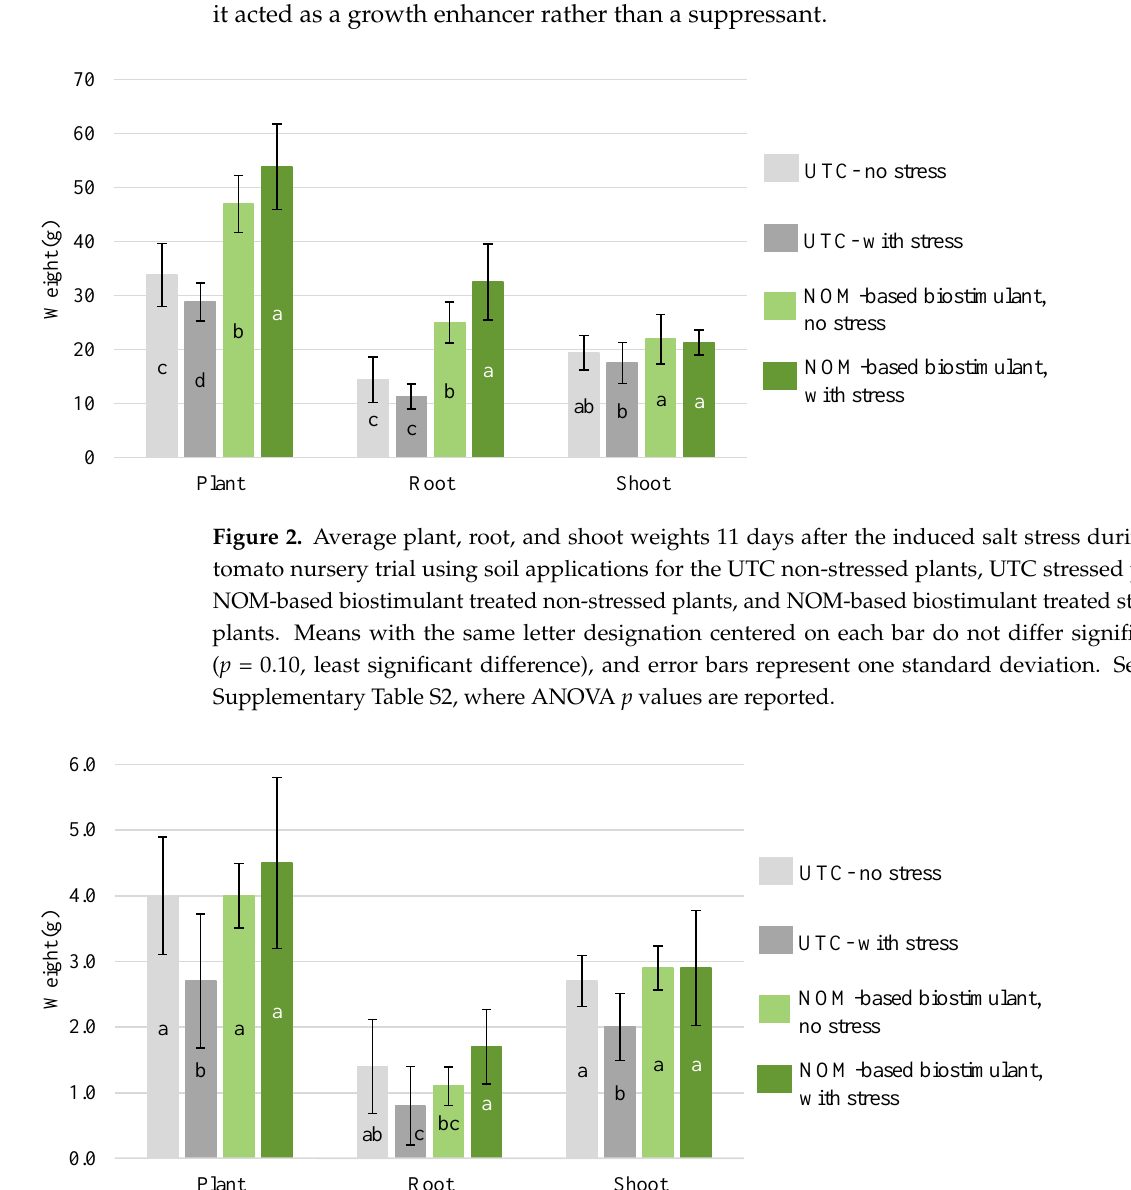
lant and the salt was validated in this trial for tomatoes.